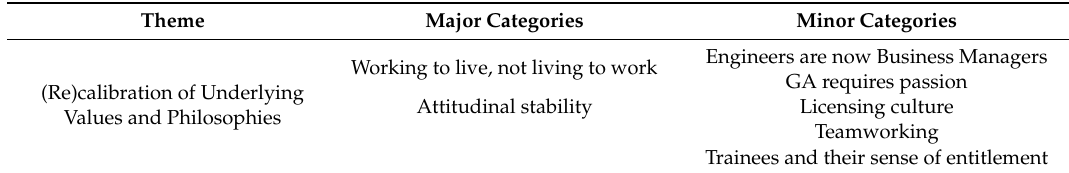
Table 5. Summary of findings for Calibration of Underlying Values and Philosophies